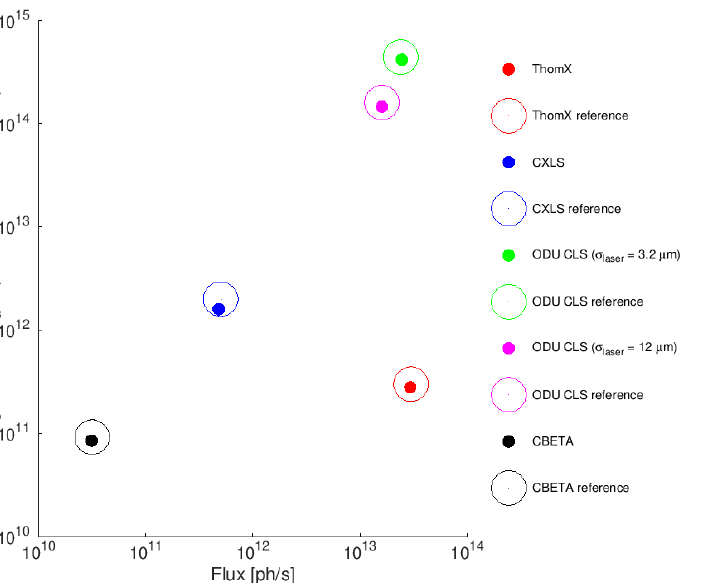
Figure 5. Comparison of total flux and average brilliance results from RF-Track with their corre- sponding referenced values. The errors obtained in RF-Track for both average brilliance and total flux are too small to be